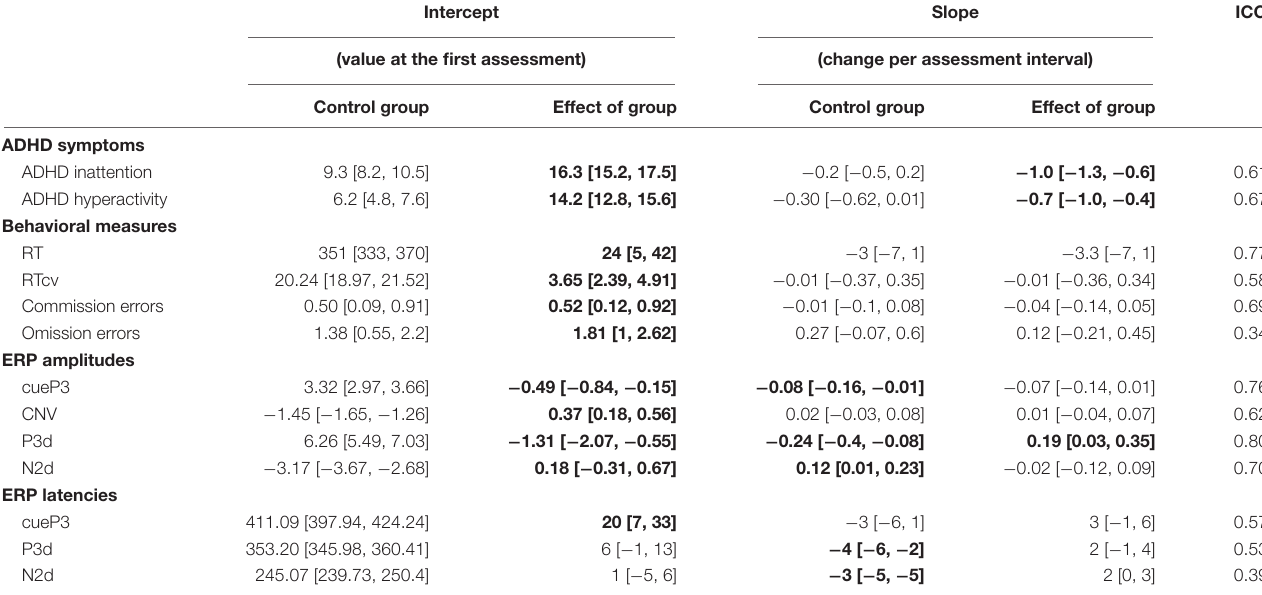
TABLE 3 | Univariate latent growth curve models describing group average values (intercepts) and average changes over time (slope) with 95% confidence interval. Intercept Slope ICC (value at the first assessment) (change per assessment